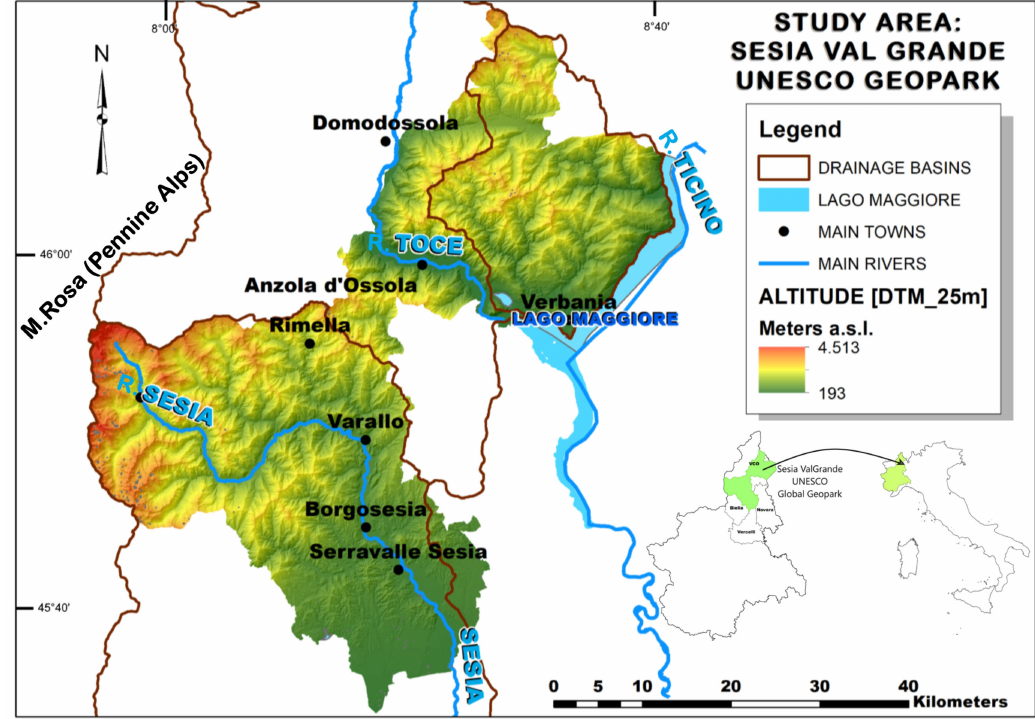
Figure 2. The study area of the Sesia Val Grande United Nations educational, scientific, and cultural organization (UNESCO) Global Geopark